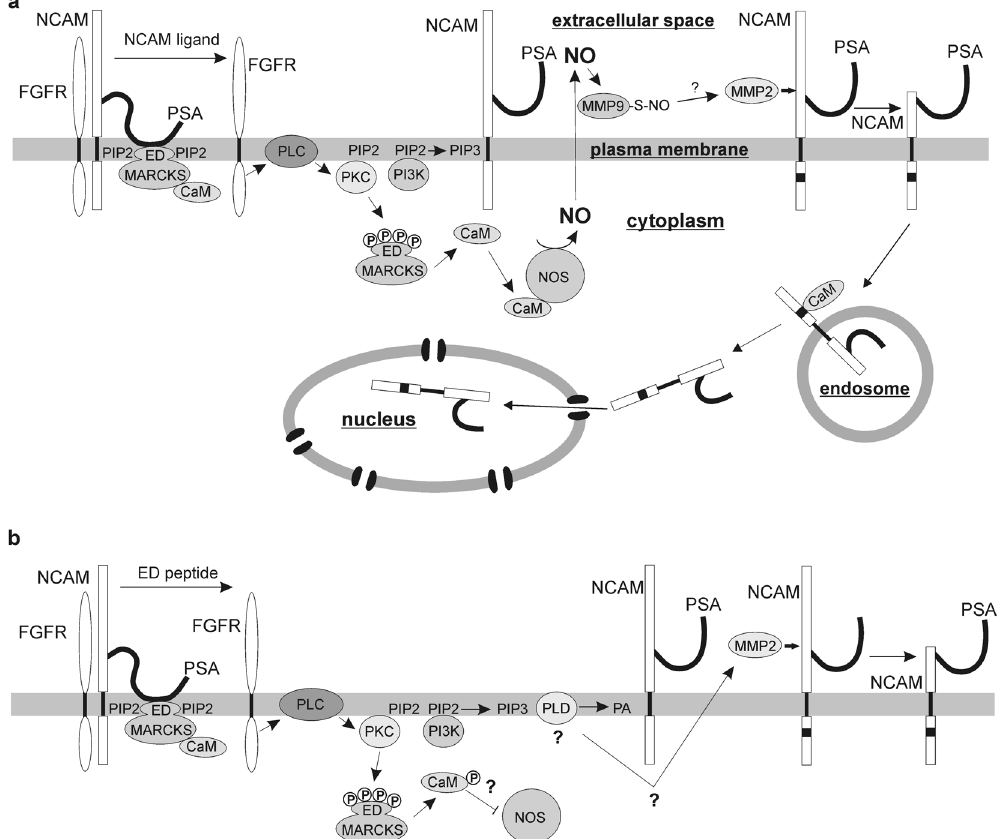
Figure 6. Proposed working model for the generation of the PSA-carrying NCAM fragment. ( a ) PSA-carrying NCAM interacts with the FGF receptor and the effector domain (ED) of non-phosphorylated MARCKS which sequesters calmodulin to the plasma membrane. Binding of NCAM ligands to PSA-NCAM leads to dissociation of the FGF receptor and PSA-NCAM and detachment of the PSA moiety from MARCKS followed by activation of the FGF receptor, PLC, PKC, and PI3K. PKC-mediated phosphorylation of the MARCKS effector domain triggers the release of membrane-bound MARCKS and dissociation of calmodulin from MARCKS. Free calmodulin binds to NOS leading to activation of NOS and production of NO, which is released into the extracellular space. S-nitrosylation of MMP-9 by NO leads to activation of MMP-9 and subsequent activation of MMP2 and cleavage of PSA-NCAM by active MMP2. After cleavage, the PSA-carrying NCAM fragment is internalized, transported to endosomes and released from the endosomal membrane into the cytoplasm involving calmodulin and imported calmodulin-independently from the cytoplasm into the nucleus. ( b ) The MARCKS-derived ED peptide like endogenous stimuli affects the interaction of the PSA moiety and MARCKS and thereby not only triggers the dissociation of the FGF receptor and PSA-NCAM, the activation of the FGF receptor, PLC and PKC and phosphorylation of the MARCKS effector domain, but also the activation of PLD, which produces phosphatidic acid. Activation of PLD and production of phosphatidic acid may lead to inhibition of calmodulin to activate NOS, but triggers the direct activation of MMP2 which cleaves PSA-